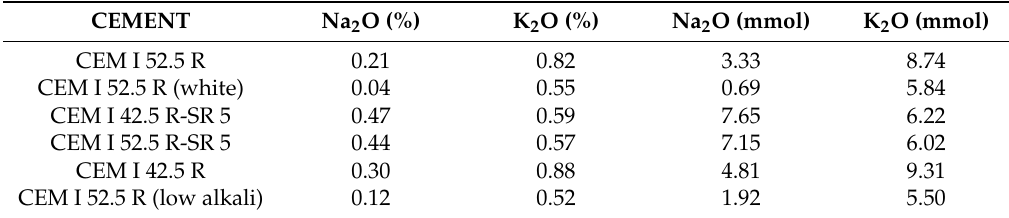
Table 9. Na 2 O or K 2 O in the pore solution (water-soluble plus released alkalis) at 28 days.